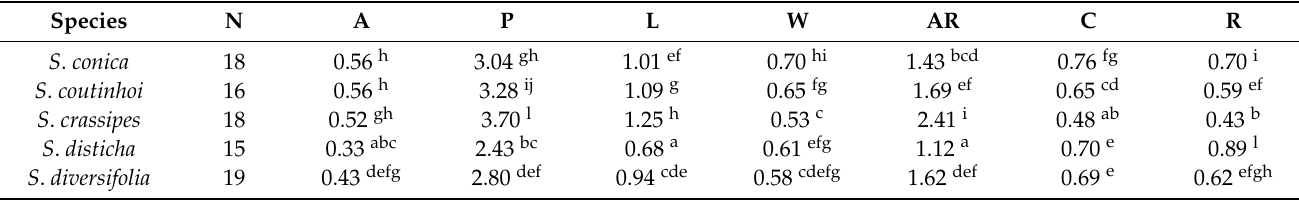
Table 4. Mean values of the area (A), perimeter (P), length of the major axis (L), width (W), aspect ratio (AR), circularity (C) and roundness (R) in the dorsal views of the Silene seeds. Values of A are given in mm 2 ; P, L, and W, in mm. Superscript letters indicate the results of Scheff é test: the mean values marked with a different letter in each column differ significantly at p < 0.05. N is the number of seeds